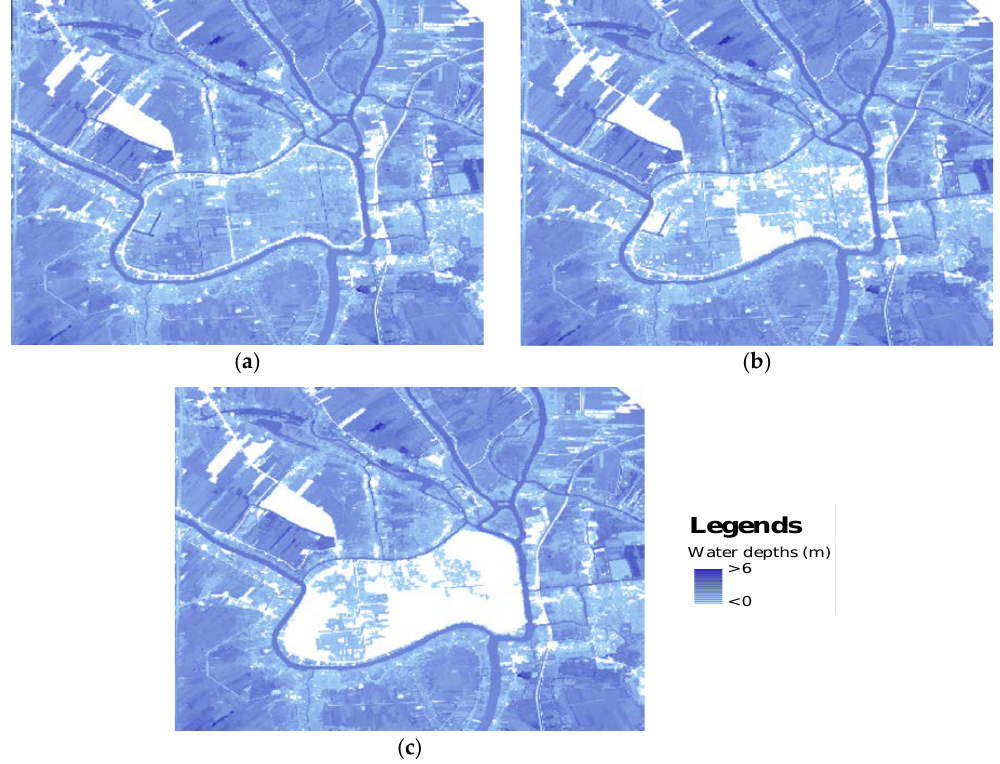
Figure 7. Example of the model simulation results, expressing computed flood depths for different combinations of flood protection measures (( a ) current situation—Scenario 1, or “business as usual”; ( b ) combination of measures—Scenario 4; and ( c ) combination of measures—Scenario 7), 2011 flood event. The combination of measures included a variety of measures such as regional, local and combinations between regional and local (Table 1).